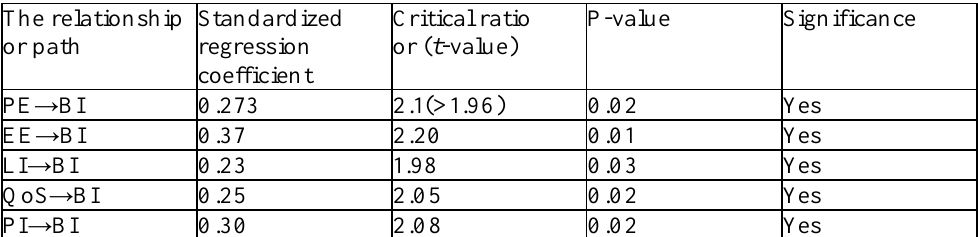
Path Coefficients and t-Values of the Hypothesis The relationship or